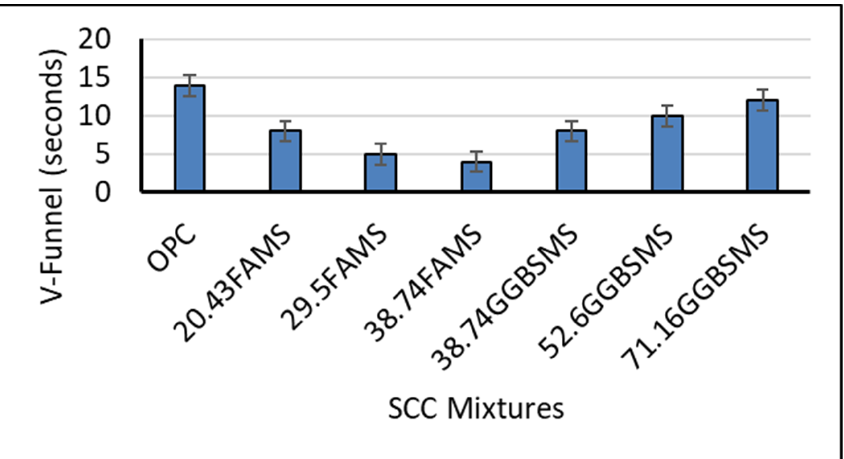
Figure 11. V-funnel results of SCC mixtures.